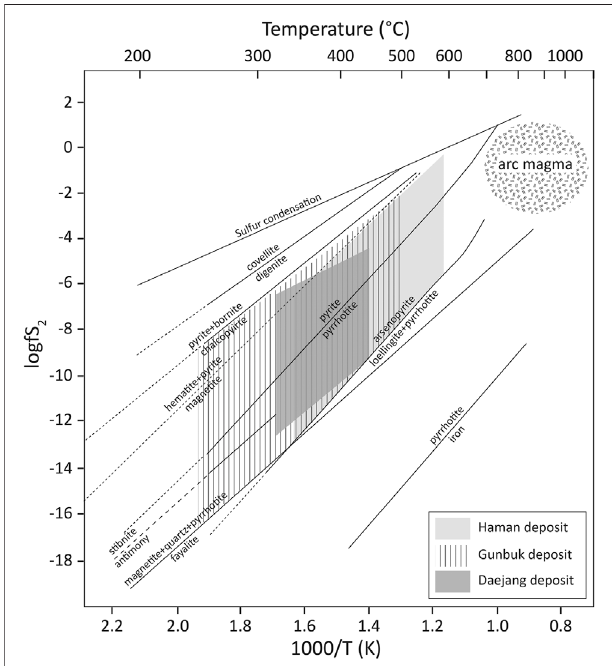
FIGURE 14 | The plot of hydrothermal temperatures versus sul fi dation states of ore mineral assemblages, as described by Einaudi (2003) with some modi fi cation. Hydrothermal fl uids of the Daejang deposit showed a higher sul fi dation state (arsenopyrite-pyrrhotite-pyrite-chalcopyrite, no magnetite) and a lower temperature range than the Haman and Gunbuk deposits (arsenopyrite-pyrrhotite-pyrite-chalcopyrite, massive magnetite).